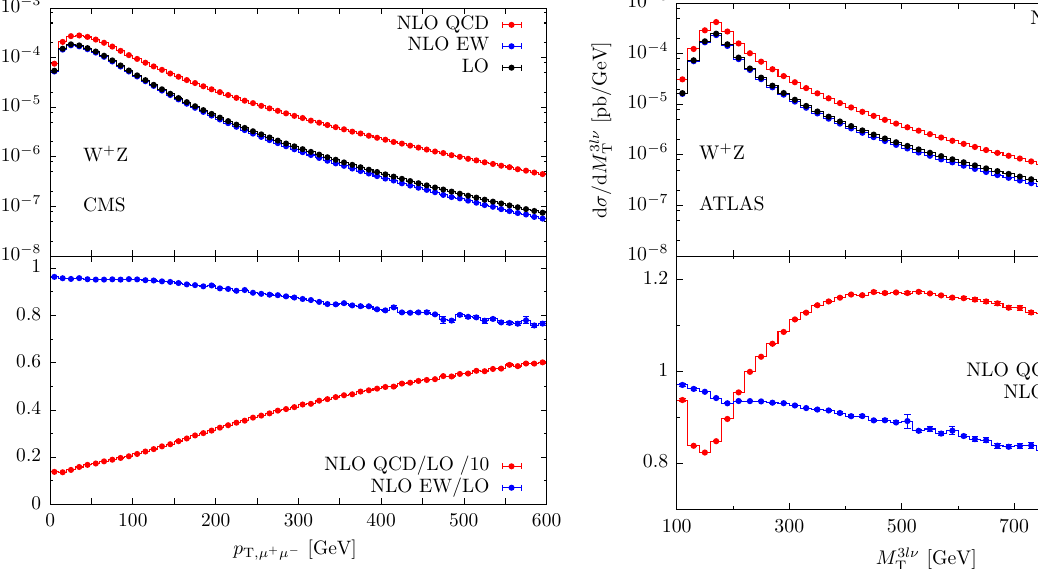
Fig. 11 Differential distribution in the transverse momentum of the muon–antimuon pair ( p T ,μ + μ − ) and in the WZ transverse mass ( M 3 l ν for the process pp → e + ν e μ + μ − at